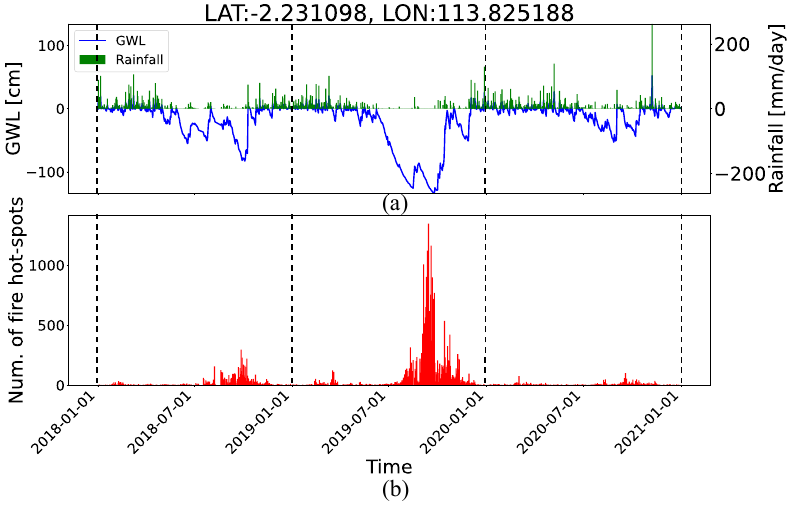
Figure 3. Time series of rainfall, GWL, and the number of fire hotspots from January 2018 to December 2020. ( a ) Rainfall and estimated GWL at a single point (latitude/longitude: −2.23/113.825) near Palangka Raya city within Frame 1. ( b ) Number of daily fire hotspots over the study area during the investigated period.